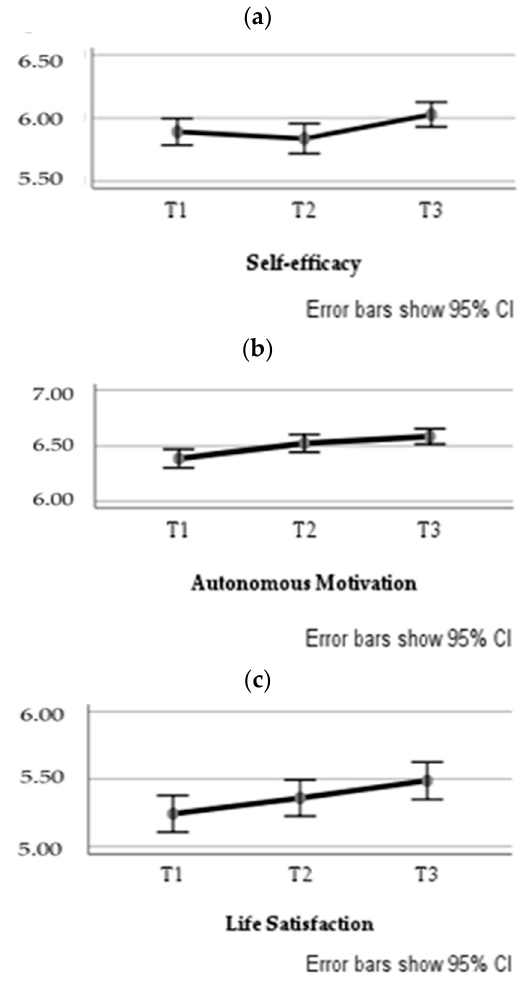
Figure 1. Estimated marginal means of self-efficacy ( a ), autonomous motivation ( b ), and life satisfaction ( c ) over the three measurement moments. Note. T1 = Time 1; T2 = Time 2; T3 = Time 3. CI = Confidence Interval.